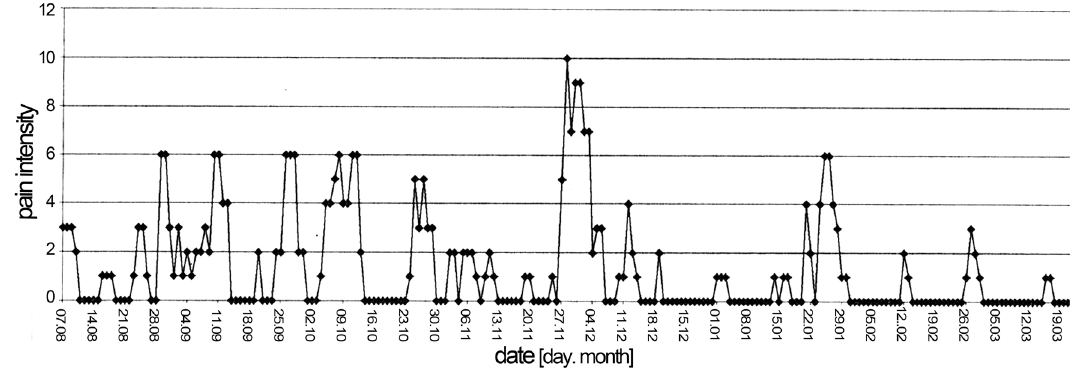
Figure 3. Musculotendinous pain, recorded by a patient with Whipple’s disease during a period of 7 months. Pain intensity on the y axis ranged from zero, indicating no pain to ten indicating maximal pain. Details see